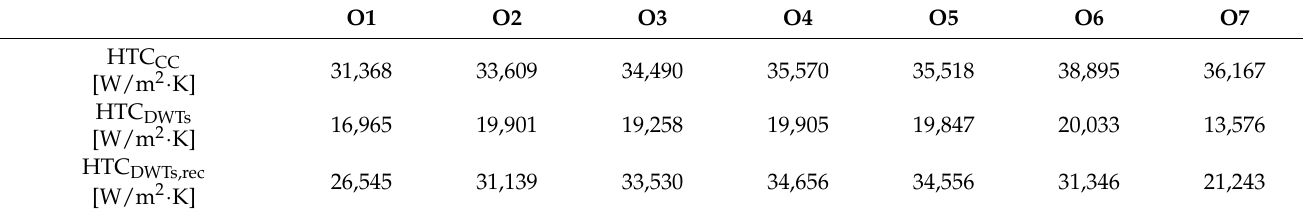
Table 2. HTC values used for cooling channels and DWTs coolant.